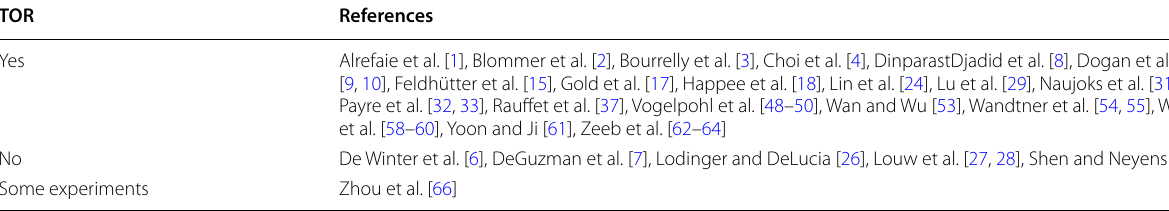
Table 3 Presence of TOR in the selected studies